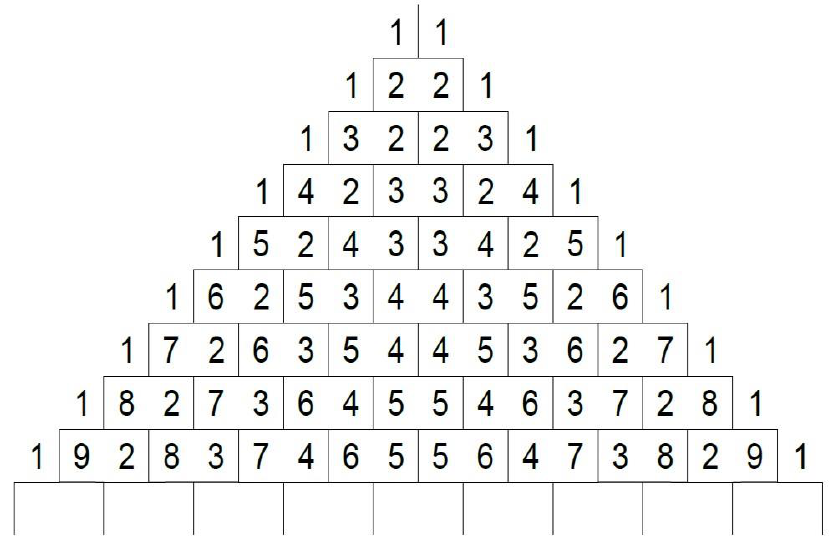
Figure 12. Design of a ten-outlet MGG. Numbers in each horizontal layer indicated relative ratios, and lengths are not to scale.